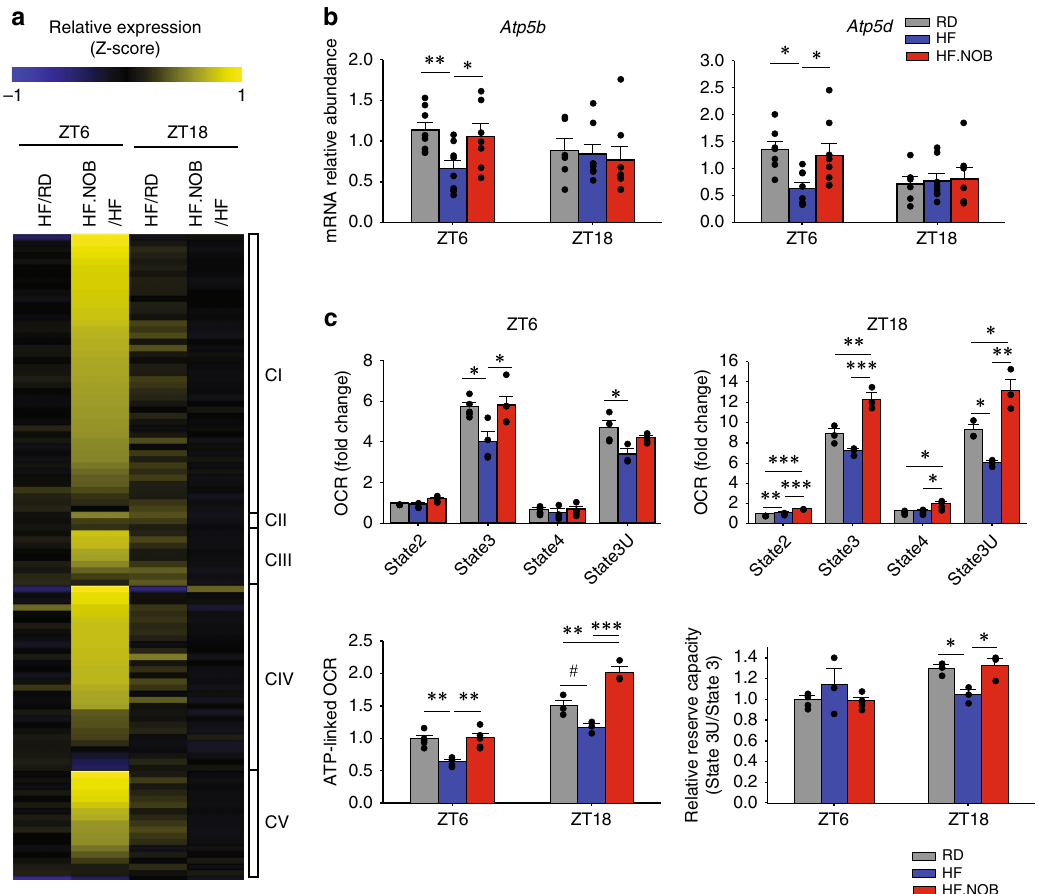
Fig. 4 NOB activated mitochondrial OXPHOS gene expression and function. Aged mice were fed with regular diet (RD), high-fat (HF) diet, or HF diet with NOB (HF.NOB). a Heat map of pairwise expression comparison for mitochondrial respiration complex genes from RNA-sequencing analysis ( n = 3). The z - score indicates the number of SDs away from the mean of expression. b Expression of two mitochondrial complex V genes known to be targets of RORs were restored by NOB (ZT6, n = 11, 10, and 10 for RD, HF, and HF.NOB, respectively; ZT18, n = 9, 8, and 8 for RD, HF, and HF.NOB, respectively). c Oxygen consumption rate (OCR), ATP-linked OCR, and relative reserve capacity in mitochondria isolated from calf muscle after 20 weeks of treatment. Average and representative assay results are shown (ZT6, n = 5, 4, and 5 for RD, HF, and HF.NOB, respectively; ZT18, n = 4). * p < 0.05, ** p < 0.01, *** p < 0.001, one-way ANOVA; # p < 0.05, t -test. Data are presented as mean ± SEM in bar (Supplementary Fig. 5a). In comparison, NOB showed over- lapping effects on redox gene expression in RD, with signi fi cant changes in Gpx1 and Sod1 mRNA levels (Supplementary Fig. 5b).